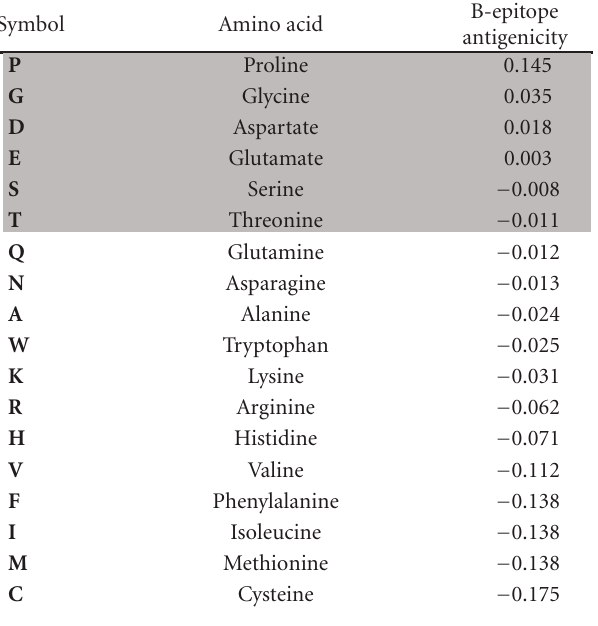
Table 1: The antigenicity index (B cell epitope) for single amino acids defined by the BepiPred server. The top 6 scoring amino acids are highlighted in grey in the various